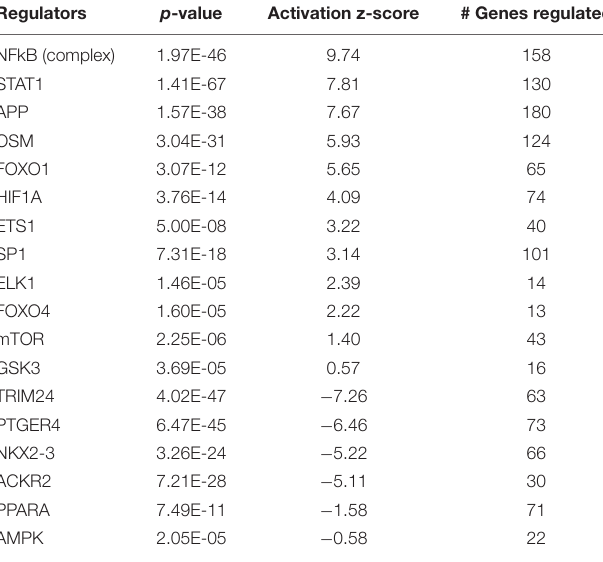
TABLE 2 | Top upstream regulators altered by intrauterine inflammation in